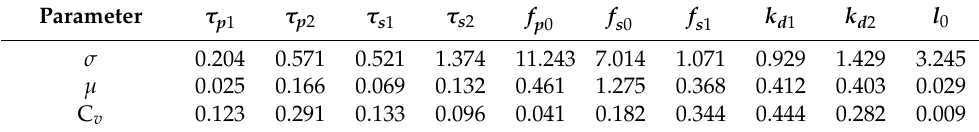
Table 3. Coefficient of variation of